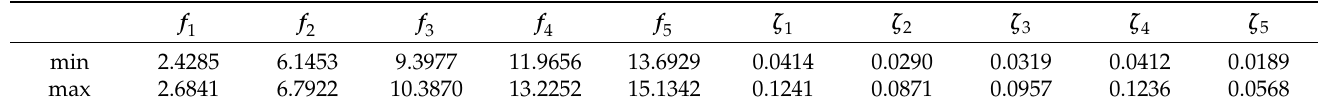
Table 2. Minimum and maximum values of frequencies and damping ratios for the 5DoF